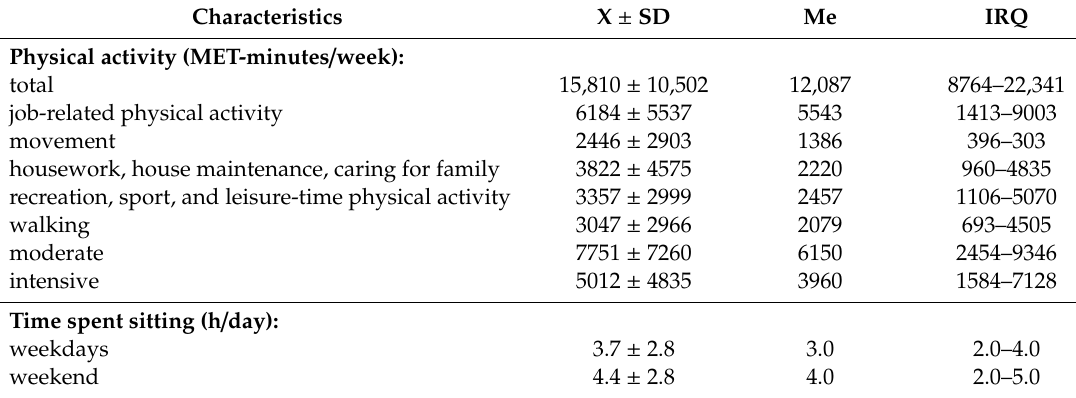
Table 3. Physical activity specified by soldiers in the long-form International Physical Activity Questionnaire (IPAQ).